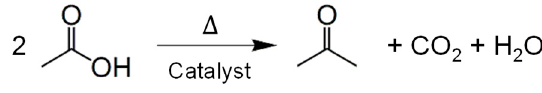
Figure 1. Acetic acid ketonisation.